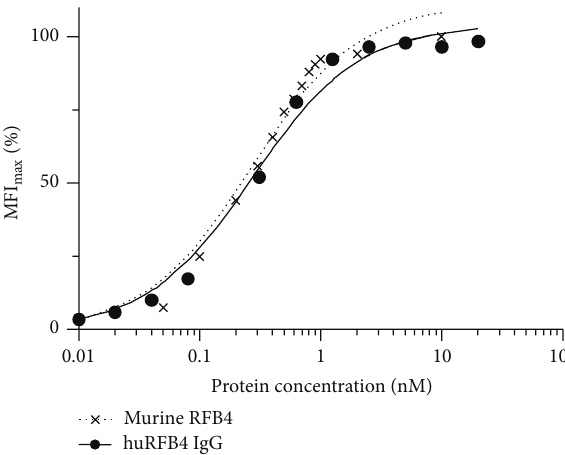
Figure 1: Equilibrium-binding curves of murine RFB4 and huRFB4 IgG. Binding activity to CD22-positive Raji cells at indicated con- centrations was determined by flow cytometry performing triplicate measurements. Bars represent standard errors (SEs) of mean values. MFI max : maximum median fluorescence